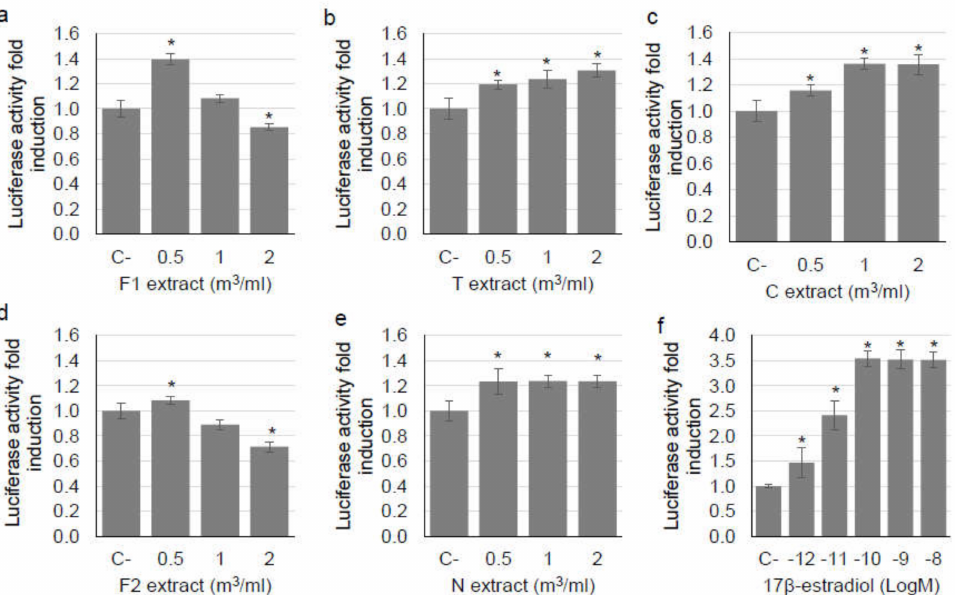
Figure 4. Estrogenic activity detected using luciferase gene reporter assay in PM 10 extracts collected in ( a ) Chiomonte (wildland fire)—F1, ( b ) Torino—T, ( c ) Ceresole Reale—C and in PM 2.5 extracts collected in ( d ) Chiomonte (wildland fire)—F2, ( e ) Novara—N. The results are expressed as luciferase activity fold induction (means and standard deviations) respect to negative control (C- = 1). ( f ) standard positive curve, obtained exposing cells to five concentrations of 17 β -estradiol (10 − 12 –10 − 8 M). * p < 0.05 vs. C- according to t